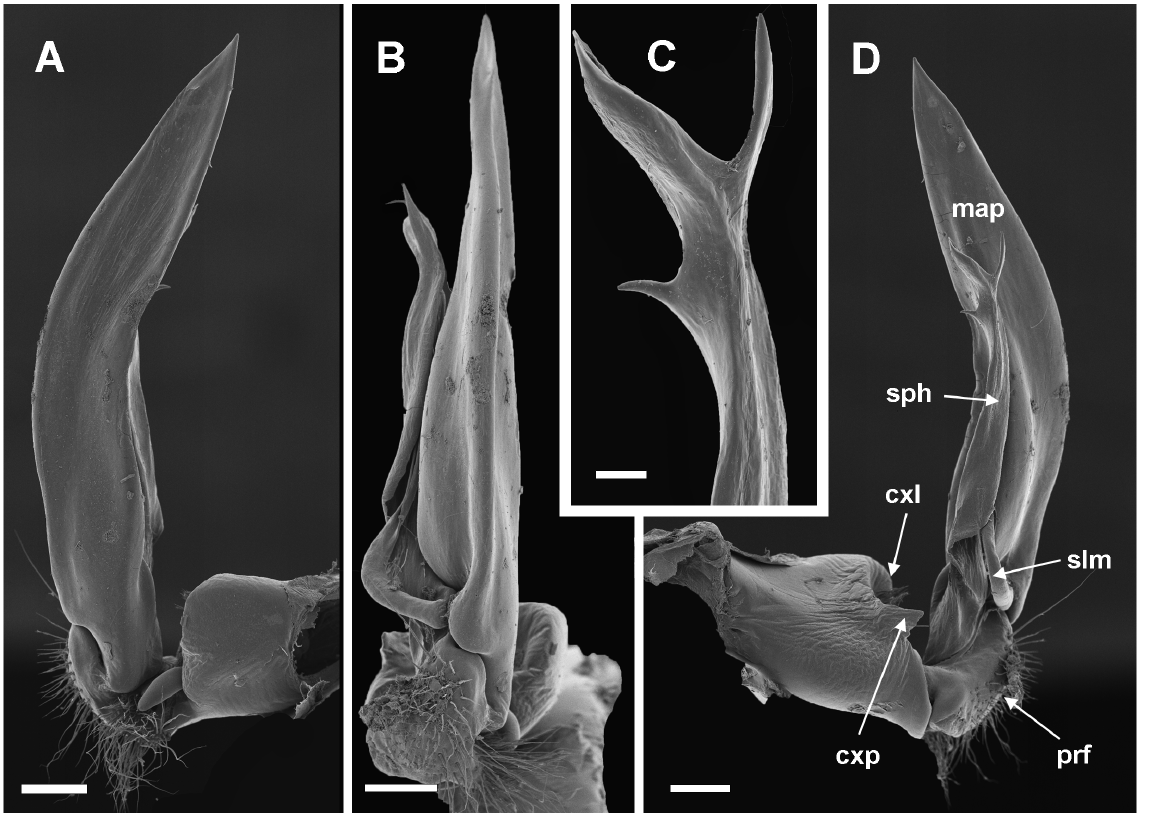
Fig. 24. Eviulisoma culter sp. nov., paratype, right gonopod. A . Mesal view. B . Ventral view. C . Tip of solenophore, lateral view. D . Lateral view. Abbreviations: cxl = coxal lobe; cxp = coxal process; map = mesal acropodital process; prf = prefemur; slm = solenomere; sph = solenophore. Scale bars: A–B, D = 0.2 mm; C = 0.05